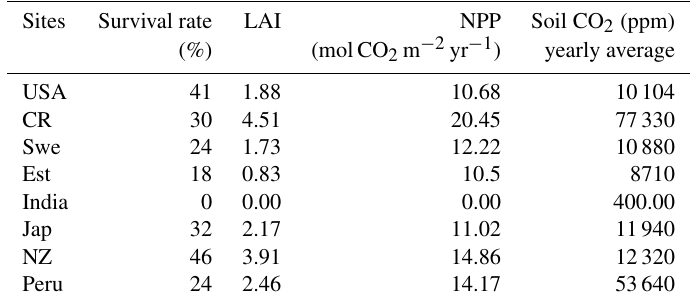
Table 4. LYCOm outputs: survival rates, weighted leaf area index (LAI), weighted NPP and weighted soil CO 2 content.